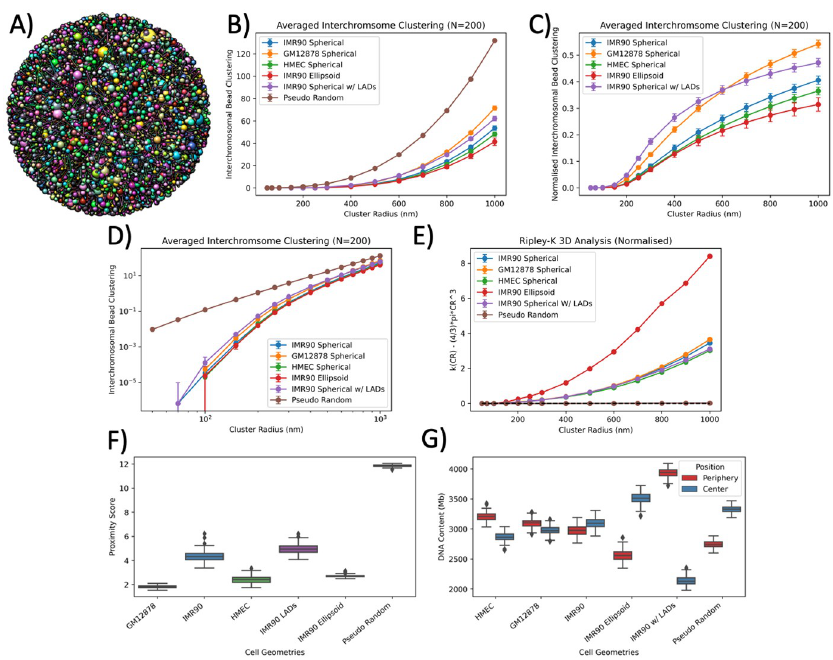
Fig 3. Geometric comparison of solved Hi-C geometries and pseudo random geometries. A) visualised example of a pseudo random geometry, beads are placed randomly within the restricted nuclear volume with no restriction of neighbouring beads. B) averaged interchromosomal bead clustering for all Hi-C cell-types and variants including the corresponding pseudo random values plotted on a linear-linear scale. C) normalised values of interchromosomal bead clustering for all Hi-C cell-types and variants using the corresponding pseudo random value as the normalisation parameter. D) same results as B) but on a log-log scale. E) Normalised 3D Ripley-K function (Eq (1)). The normalisation results in complete spatial randomness giving a y-value = 0 (shown by the dotted black line) for all cluster radii. Edge correction is applied for as 1/ V , where V is the fraction of overlapping volume of the cluster radius s s and the nuclear radius. All values are the average of 200 inferred geometries and error bars are the standard deviation. F) proximity score (lower value indicates a better optimisation of the contact constraints), which is a measure of the average euclidean distance constraint placed on TADs being proximal to one another from the Hi-C data. G) Spatial distribution of DNA content within the inferred geometries being place in either the central of peripheral half for the nuclear